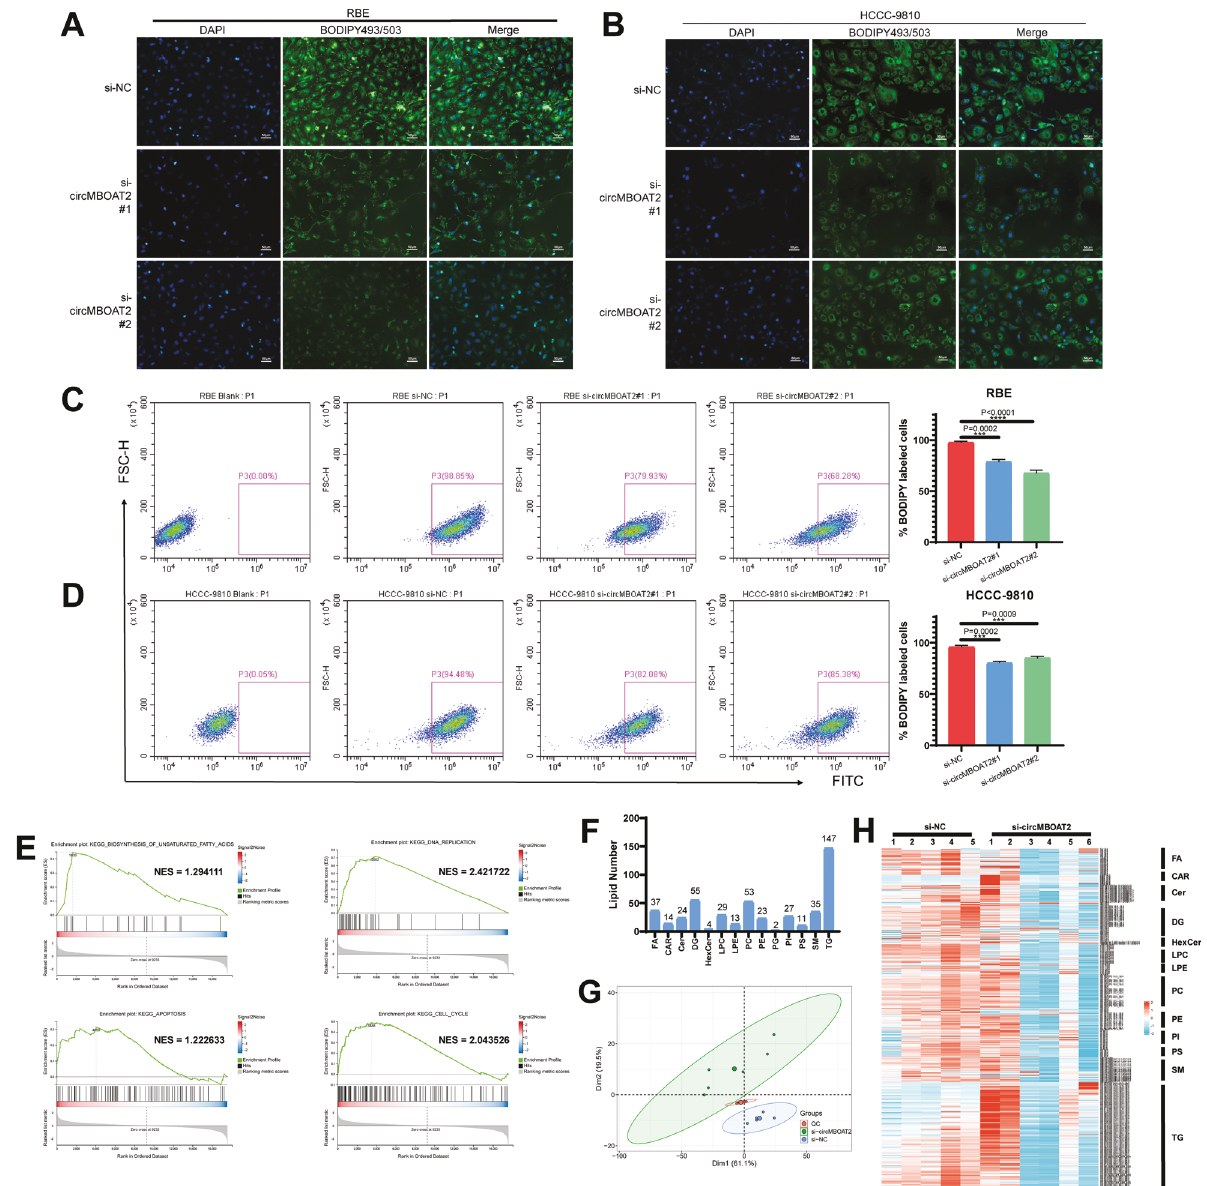
Fig. 3 CircMBOAT2 regulates lipid metabolism reprogramming. A , B The neutral lipid droplets were detected by staining with BODIPY 493/ 503 in RBE and HCCC-9810 cells transfected by si-NC, si-circMBOAT2#1 and si-MBOAT2#2. Nuclei were stained with DAPI. Scale bar = 50 μ m. C , D Flow cytometry to detect the neutral lipid droplets stained with BODIPY 493/503 in RBE and HCCC-9810 cells. FITC-A was used to detect BODIPY 493/503. E The circMBOAT2 knockdown group was compared with the control group for GSEA analysis. NES normalized enrichment score. F Lipid species identi fi ed in lipidomics analysis, HCCC-9810 cells transfected with si-NC or si-circMBOAT2#1. FA fatty acids; Car carnitines, Cer ceramides, DG diradylglycerolipids, HexCer hexceramides, LPC lysophosphatidylcholines, LPE lysophosphatidylethanolamines, PC phosphatidylcholines, PE phosphatidylethanolamines, PG phosphatidylglycerols, PI phosphatidylinositols, PS phosphatidylserines, SM sphingomyelins, TG triradylglycerolipids. G HCCC-9810 cells were transfected with si-NC or si-circMBOAT2#1 for lipid principal component analysis (PCA). H Heat map of changes in lipid species. changes occurred in circMBOAT2-silenced or FASN-silenced ICC used. Consistent with the results of functional assays using siRNA, cells (Fig. S6B). Except for C16:0, no signi fi cant differences in TVB-2640 inhibited cell proliferation and promoted both early and saturated fatty acids were found, while unsaturated fatty acids late stages of apoptosis and G0/G1 cell cycle arrest in HCCC-9810 were different, and the trend was more obvious in unsaturated cells (Fig. S5A – C). fatty acids with more unsaturated bonds or fewer carbons We next compared the lipid levels among control, cir- (Fig. S6C, D). These data suggested that the lipid metabolism cMBOAT2-silenced, or FASN-silenced ICC cells by lipidomics. reprogramming functions of circMBOAT2 in promoting ICC PCA analysis indicated that the downregulation of FASN in ICC progression rely on the FASN pathway. The level of unsaturated cells was parallel to circMBOAT2 silencing (Fig. 7F). The altered fatty acids, especially polyunsaturated fatty acids, is thus lipid species in circMBOAT2-silenced and FASN-silenced ICC cells signi fi cantly altered in ICC cells. are presented (Fig. S6A). In terms of fatty acids, semblable Cell Death and Disease (2023)